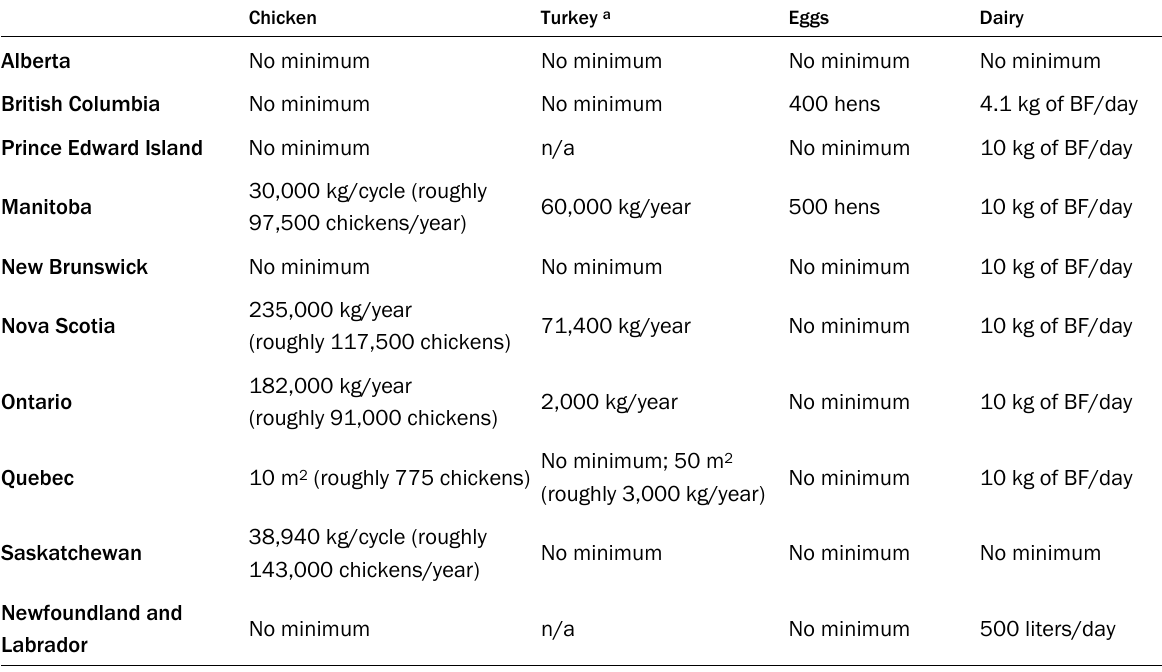
Table 2. Minimum Quota Holding